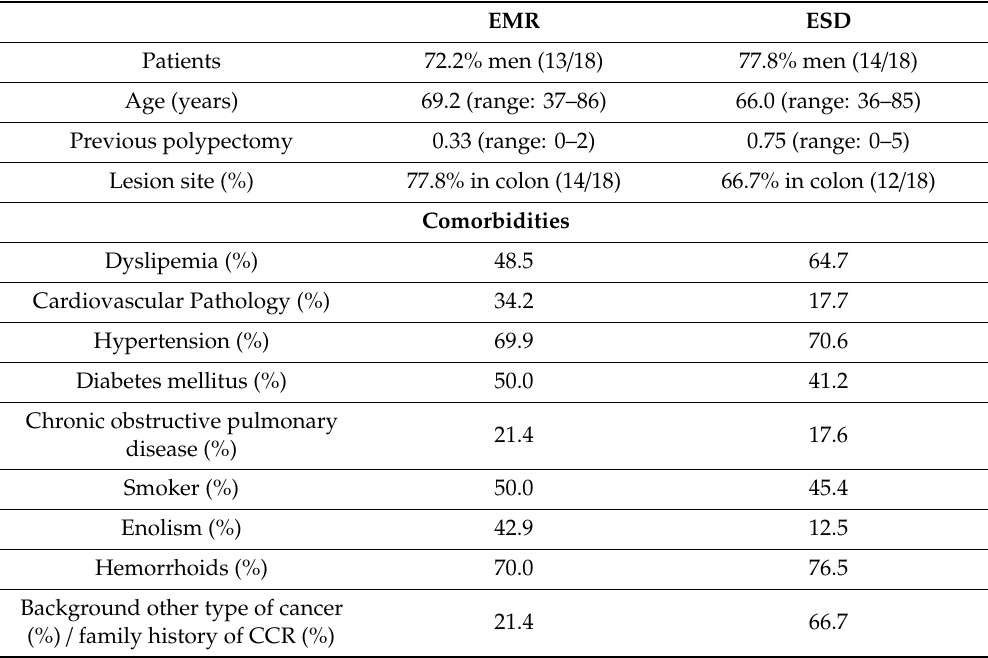
Table 1. Demographic and clinical data (mean).